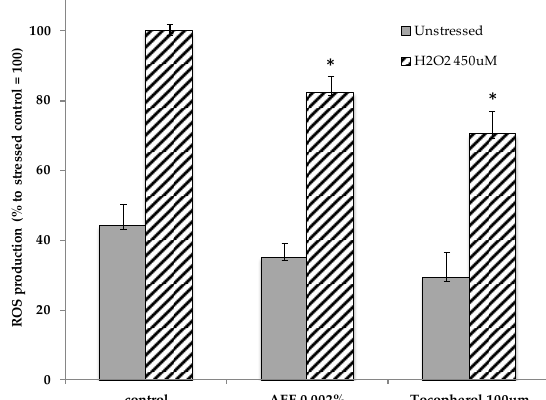
Figure 2. Effect of AEE on Superoxide Dismutases (SOD) in lymphatic endothelial cells. The gene expression level of the Cu/Zn-SOD and Mn-SOD was measured in HDLEC incubated with AEE or TGF-β, used as positive control. All determinations were conducted in triplicate and the results are expressed as mean ± SD. * p < 0.05.